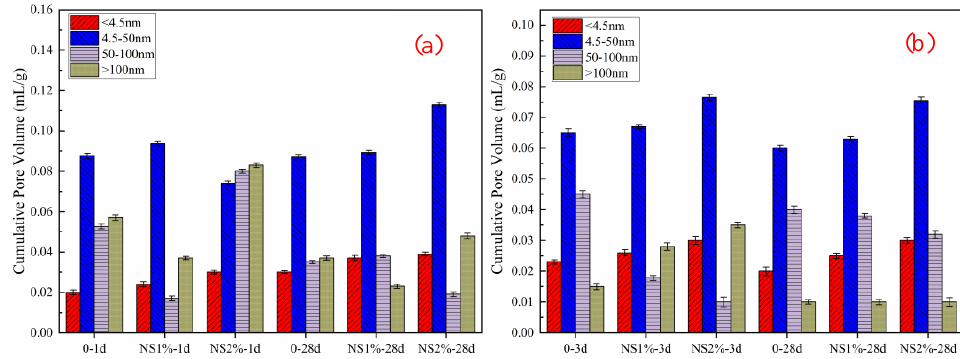
Figure 12. Pore size distribution of cement paste: ( a ) HBSAC cement; ( b ) P·O 42.5 cement.